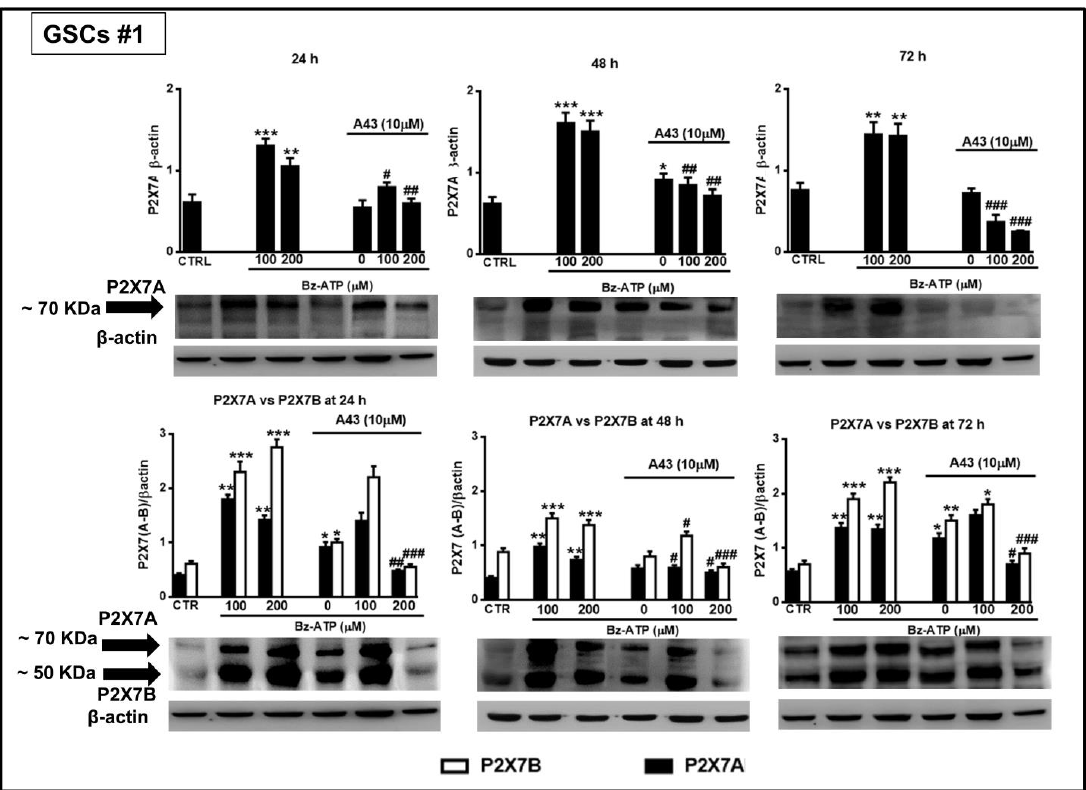
Figure 13. Modulation of the protein levels related to the P2X7R splice variants A and B in GSCs #1 exposed to BzATP. GSCs #1, cultured up to their confluence in vitro, were harvested at di ff erent time points after their exposure to BzATP and / or A438079. Protein levels of P2X7A and P2X7B isoforms were determined by western blot analysis. Immunoblots were obtained by exposing membranes to two antibodies, one recognizing only proteins at about 70 KDa and the second one recognizing proteins at about 70 and 50 KDa, respectively. Immunoblots were then re-probed with an antibody against β actin and quantified by densitometric analysis, the values of which, normalized to β actin used as an internal control, are reported in the histograms. The band of β -actin is the same for the blots at each time period, as the same membrane was first incubated with one antibody and then, after stripping, with the other antibody against the P2X7RA or B subunits. Densitometric values are the mean ± SEM of three independent experiments with very similar results. * p < 0.05, ** p < 0.01, *** p < 0.001: statistical significance vs. untreated cells (CTR); # p < 0.05, ## p < 0.01, ### p < 0.001: statistical significance vs. cells treated with BzATP (one-way ANOVA plus Dunnett’s test).